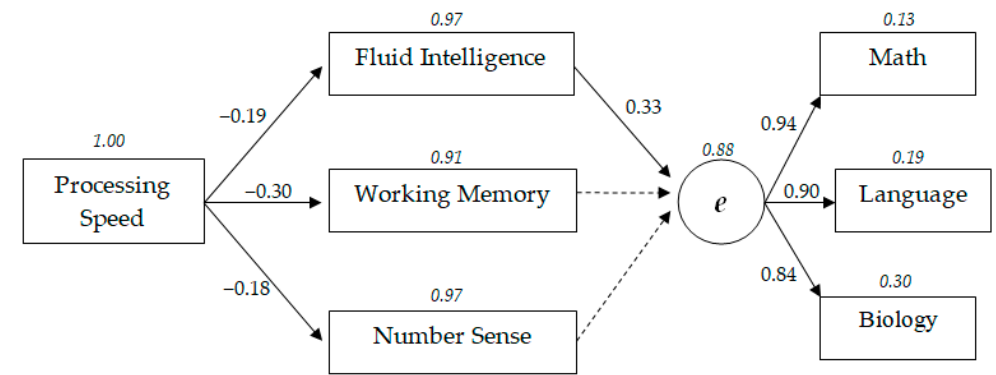
Figure 2. Model with relationships between cognitive abilities and general academic achievement in secondary school education.